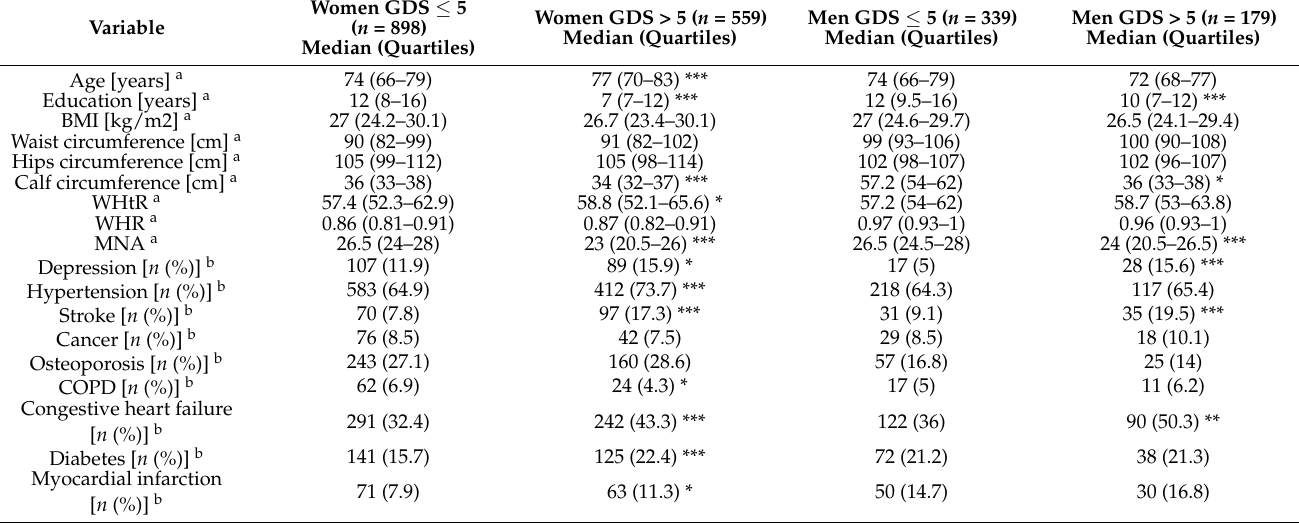
Table 2. Comparison of anthropometric variables, MNA, and prevalence of chronic diseases in female and male groups divided according to GDS score (GDS ≤ 5 vs. GDS > 5 separately in women and men).